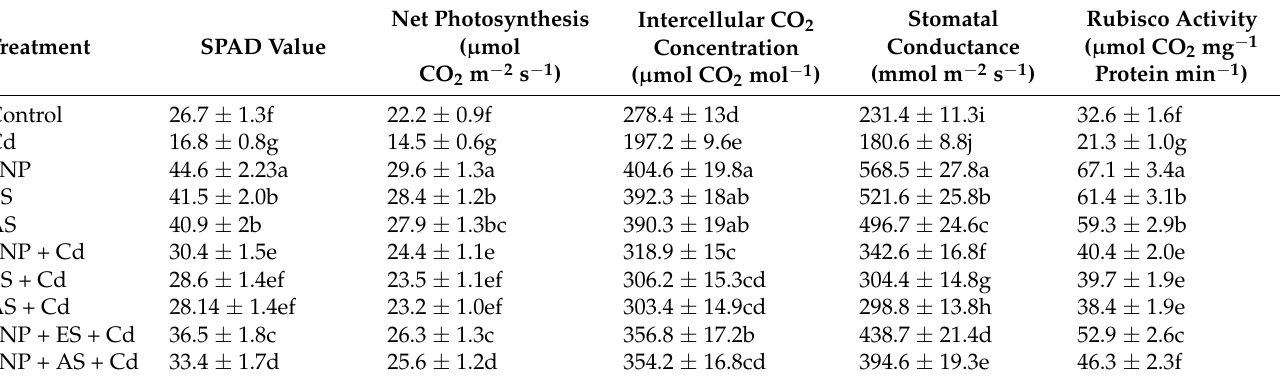
Table 2. Effect of 100 µ M of SNP (NO donor) and 200 mg S kg − 1 soil of elemental sulfur (ES) or ammonium sulfate (AS) in the presence or absence of 200 mg Cd kg − 1 soil on net photosynthesis, intercellular CO 2 concentration, chlorophyll content (SPAD values), Rubisco activity, and electron transfer rate (ETR) in mustard ( Brassica juncea cv. Giriraj) at 30 days after sowing. Data are presented as treatment mean ± SE ( n = 4). Data followed by same letter are not significantly different as determined by LSD test at p < 0.05. Cd; Cadmium; SNP, sodium